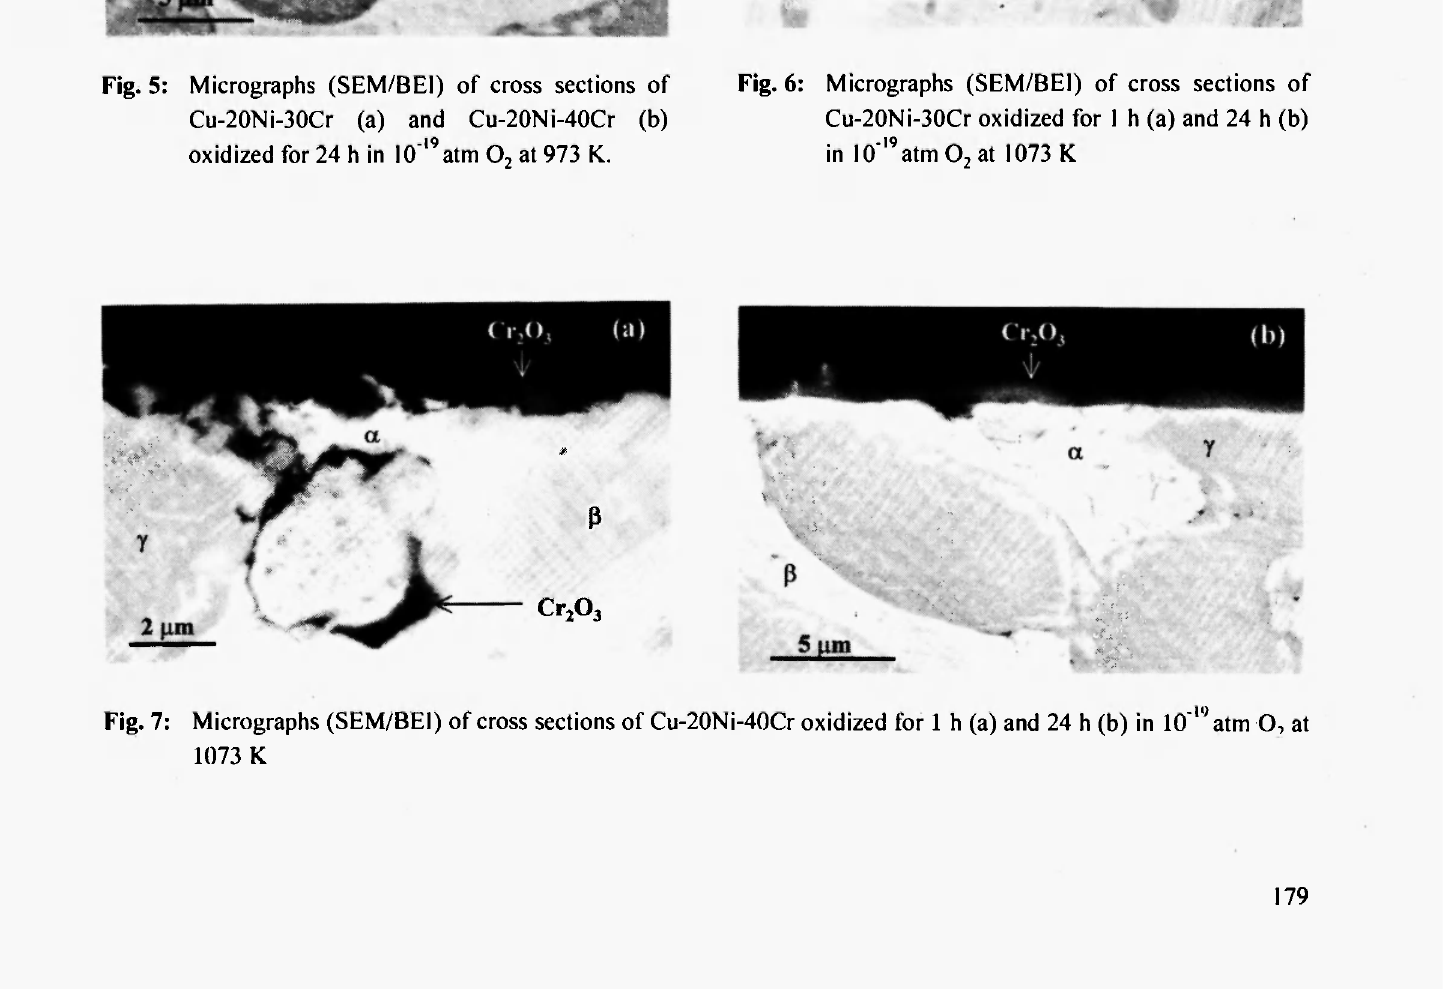
Fig. 6: Micrographs (SEM/BE1) of cross sections of Cu-20Ni-30Cr oxidized for I h (a) and 24 h (b) in I0' ,9 atm 0 2 at 1073 Κ